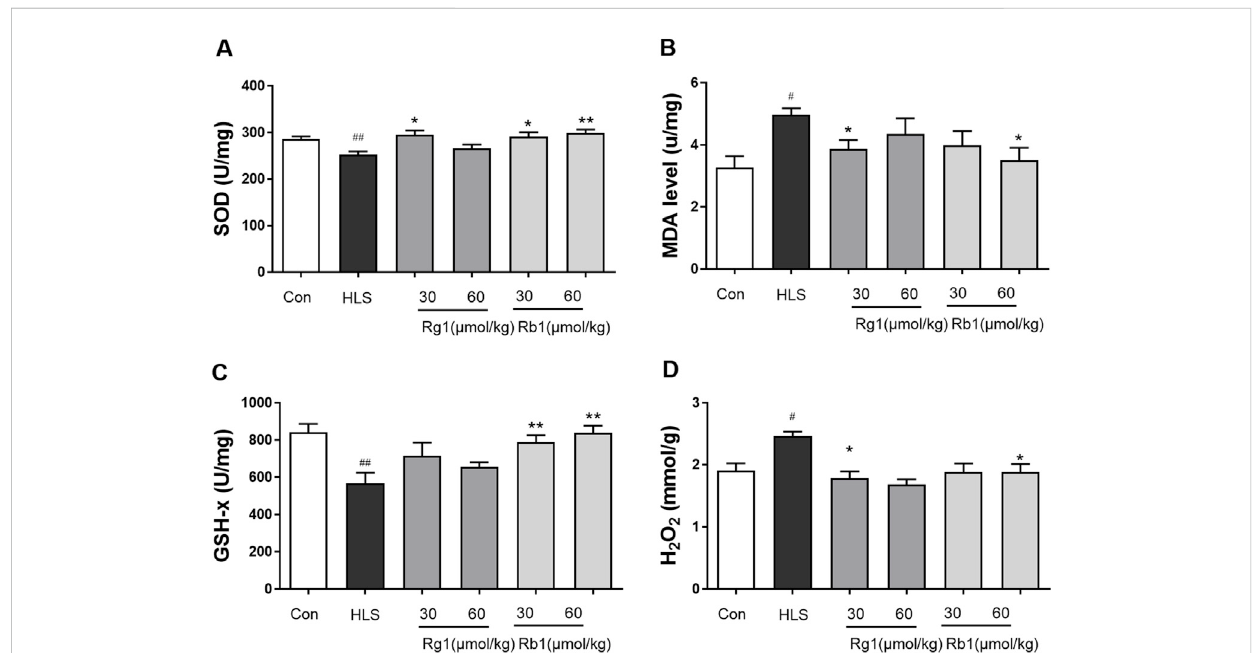
FIGURE 3 The effect of ginsenosides Rg1 and Rb1 on oxidative stress markers in hindlimb suspension (HLS) rats. (A) SOD activity, (B) MDA level, (C) GSH-Px activity, and (D) H 2 O 2 contents in the prefrontal cortex. Data represent means ± SEM; N = 6 rats per group. # p < 0.05, ## p < 0.01, signi fi cantly different from control; * p < 0.05, ** p < 0.01, signi fi cantly different from HLS